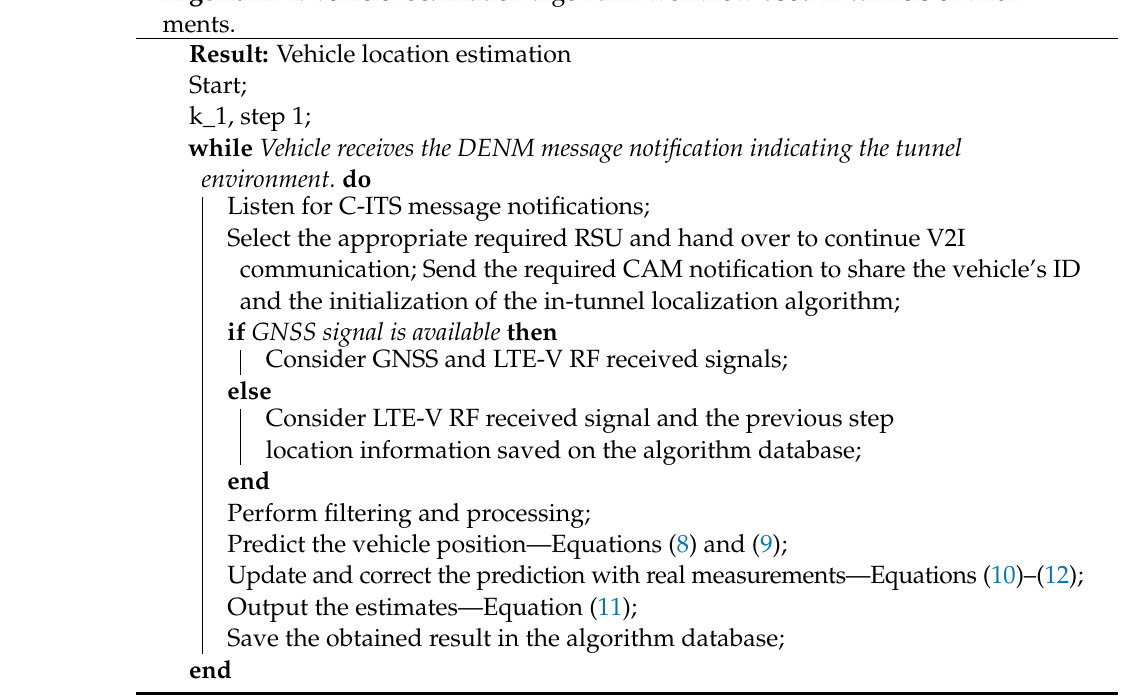
Algorithm 1: Vehicle localization algorithm workflow used in tunnels environ-